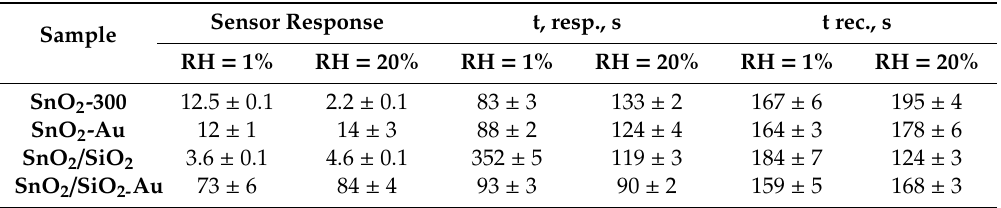
Table 5. Sensor properties of SnO 2 -300, SnO 2 -Au, SnO 2 / SiO 2 and SnO 2 / SiO 2 -Au towards 100 ppm C 2 H 5 OH at 300 ◦